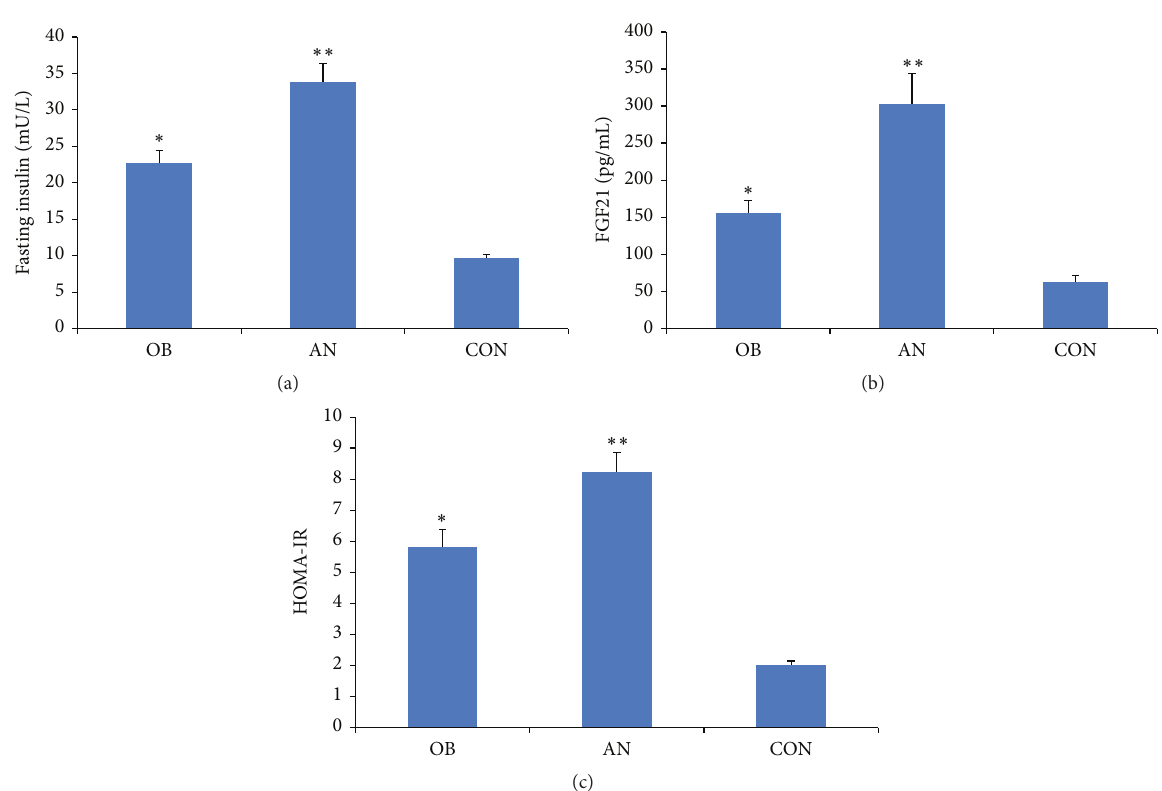
Figure 2: Comparison of insulin resistance and FGF21 among 3 groups. (a) Compared with OB group, AN patients had higher fasting insulin ( 𝑃 < 0.05 ). (b) HOMA-IR in AN group was higher than inOB group, but the difference is not significant. (c) ANgroup had the highest level of FGF21 (303.13 ± 254.43 pg/mL); the serum levels of FGF21 of OB group and CON group were 155.54 ± 108.10pg/mL and 62.20 ± 63.15 pg/mL, respectively. Graphs depict the value of mean and SEM. OB: simple obese group, AN: obese groupwith acanthosis nigricans, and CON: control group. ∗ 𝑃 < 0.05 compared with all other groups, ∗∗ 𝑃 < 0.05 compared with all other